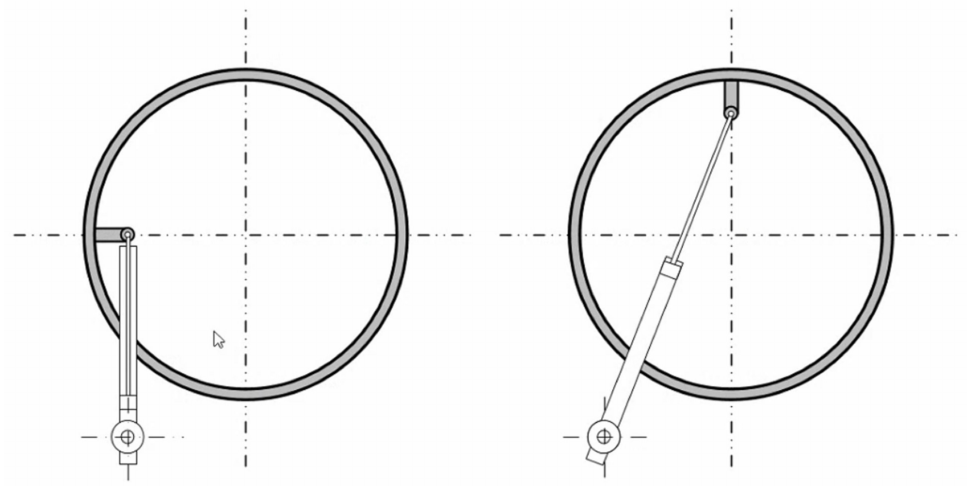
Figure 8. Layout of Hydraulic Pitch-Control